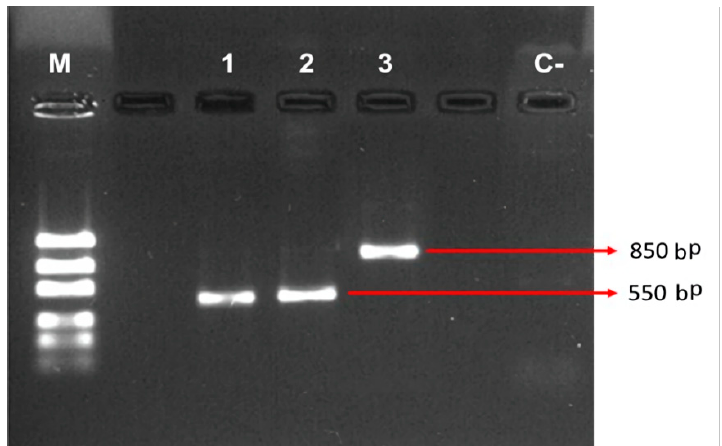
Figure 1. Verification of amplification of the internal transcribed spacer region (ITS) region by 1% agarose gel electrophoresis. The bp values shown are approximated. Code 2 corresponds to Colletotrichum gloeosporioides .